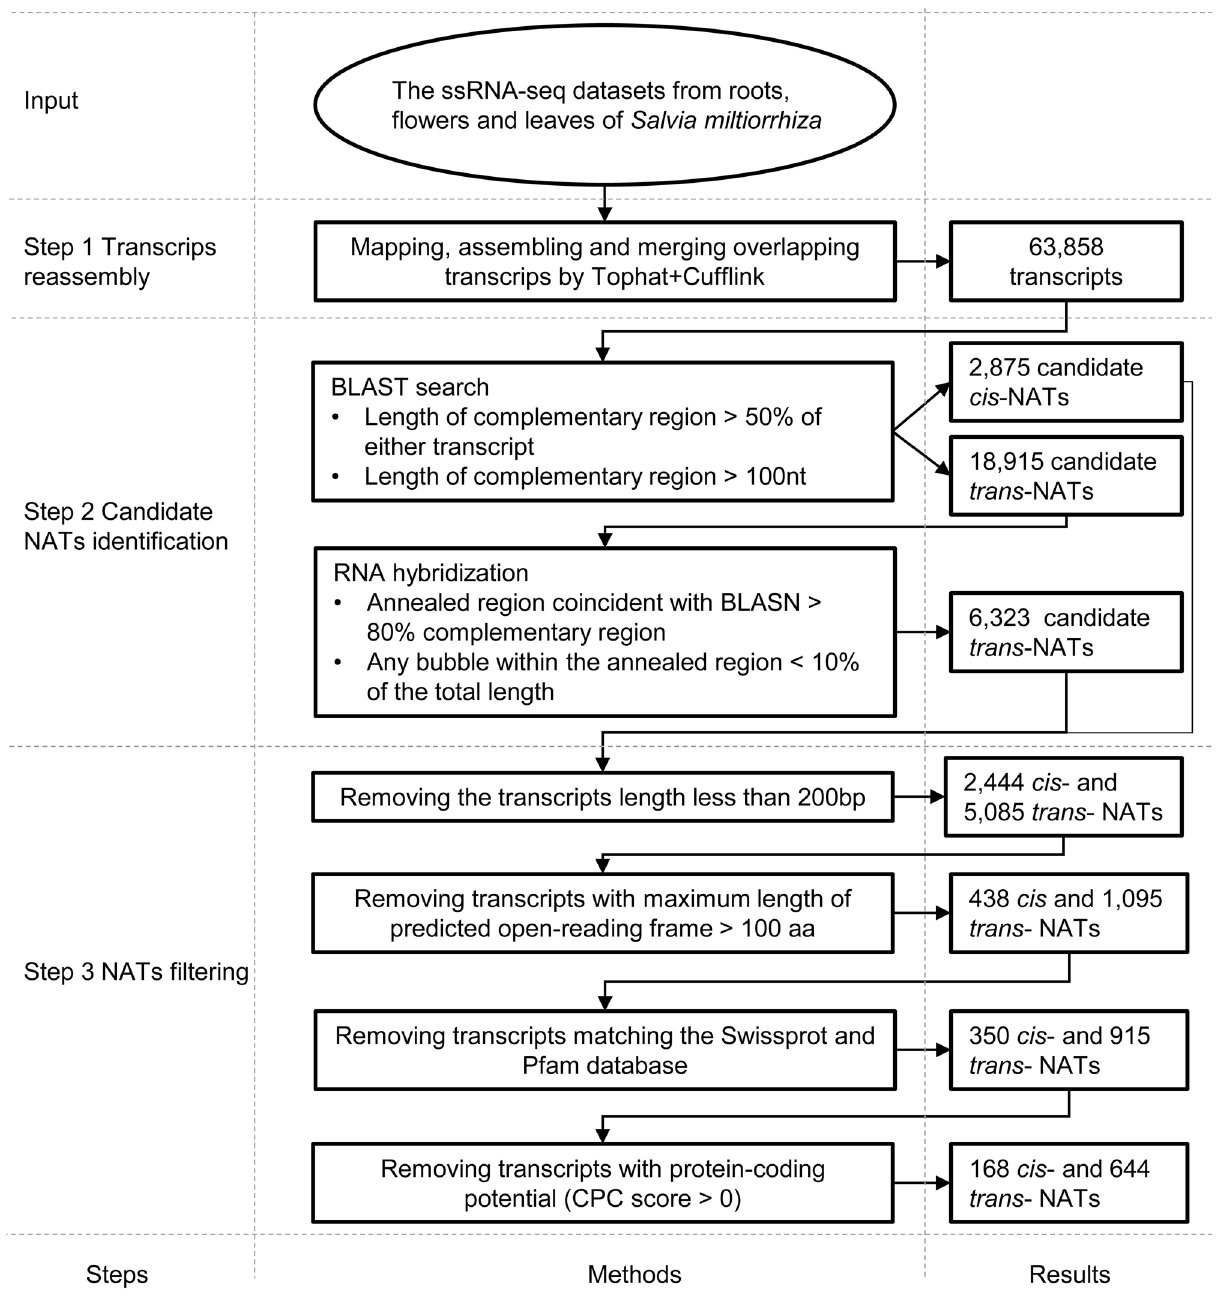
Figure 1. The bioinformatics pipeline used to identify NATs in S. miltiorrhiza . The figure has three columns. The main steps of the pipeline are shown in the left column. The detailed analytical processes are shown in the middle column. The results produced by a particular process are shown in the right